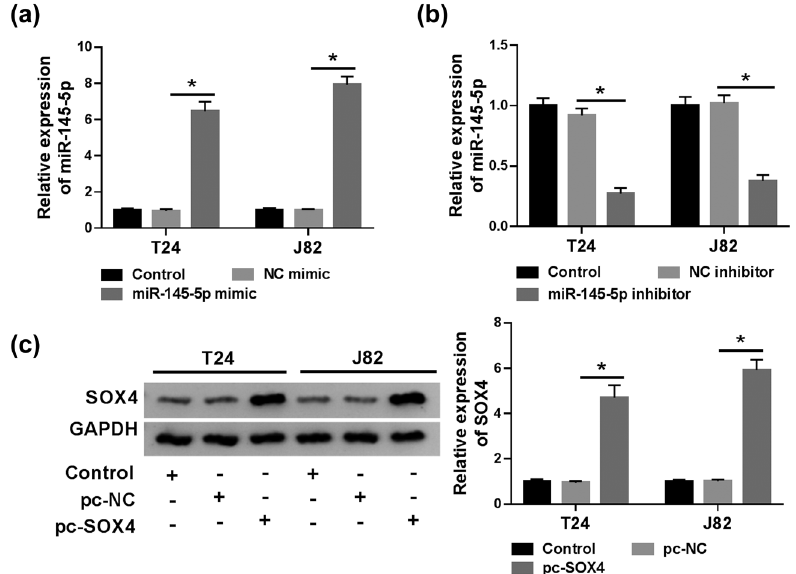
Figure S1: Transfection e ffi ciency of miR - 145 - 5p mimic, miR - 145 - 5p inhibitor, and pc - SOX4 in T24 and J82 cells. ( a ) T24 and J82 cells was transfected with NC mimic or miR - 145 - 5p mimic, respectively. And the expression of miR - 145 - 5p was detected by RT - qPCR. ( b ) The expression of miR - 145 - 5p in cells transfected with NC inhibitor or miR - 145 - 5p inhibitor were evaluated by RT - qPCR. ( c ) T24 and J82 cells was transfected with pc - NC or pc - SOX4, respectively. And the protein level of SOX4 was detected by western blot. * P <